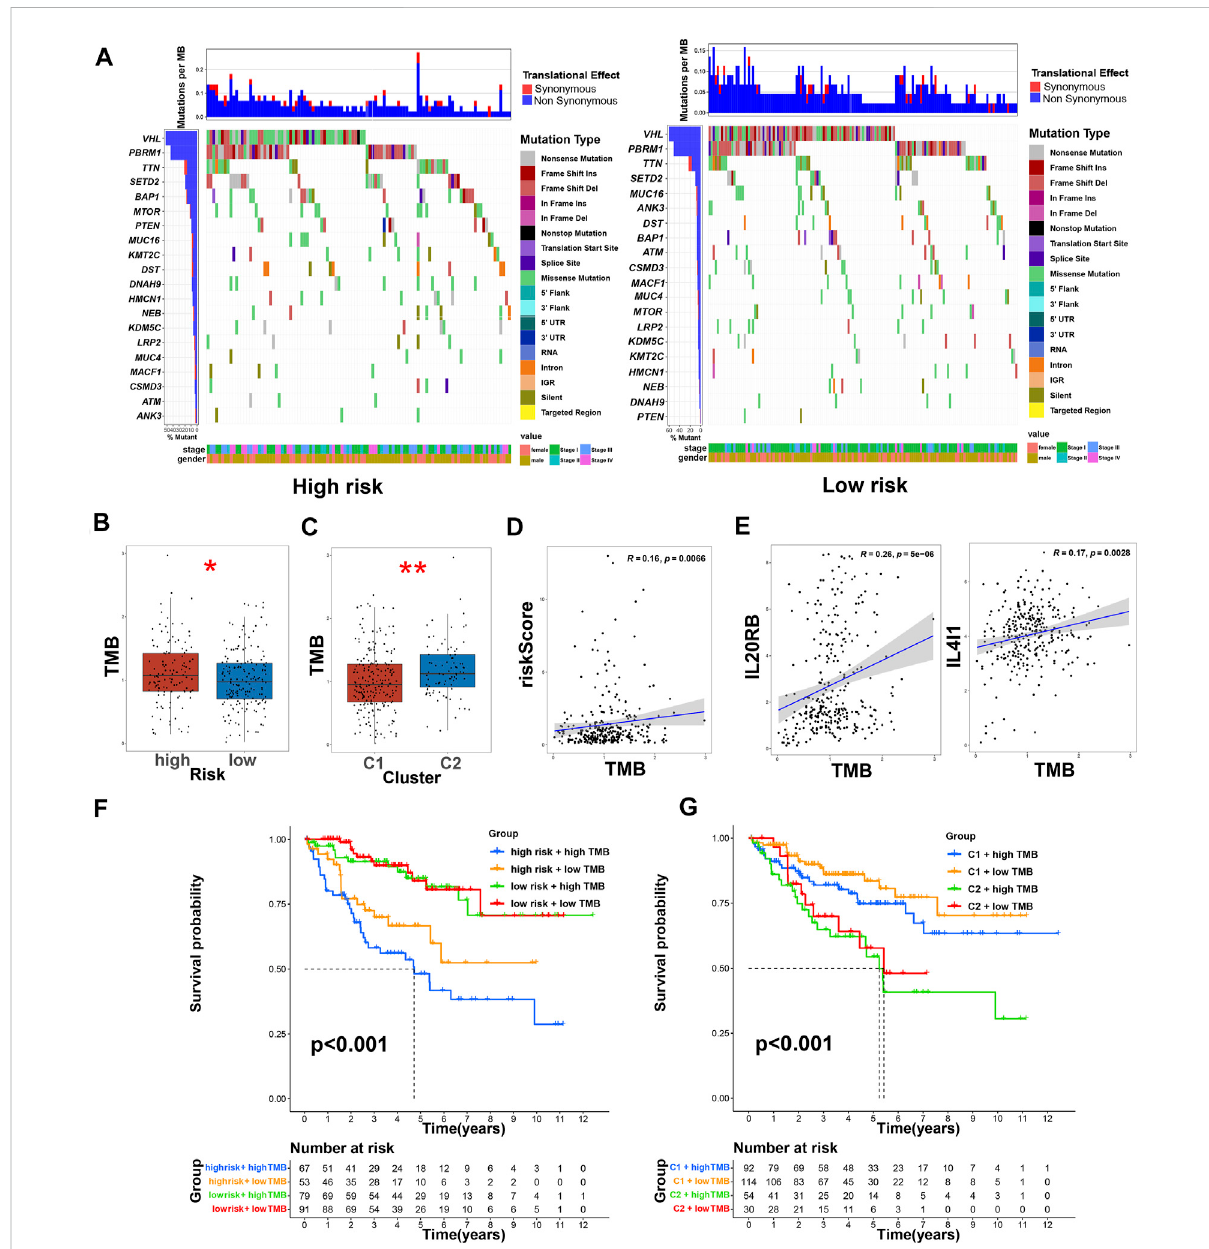
FIGURE 11 TMB and immunotherapy prediction ofccRCC patients. (A) The comparison of mutations of differentiallyexpressedTRGsinhigh- and low-risk groups; (B) thecomparisonofTMBbetweenlow-andhigh-riskgroups,*means p < 0.05; (C) thecomparisonofTMBbetweenclusters,**means p < 0.01; (D) the correlation of risk score and TMB score; (E) the correlation of TRGs and TMB scores; (F) Kaplan – Meier survival curves of OS of patients amongdifferentgroups basedonrisk scoresand TMB scores; (G) Kaplan – Meiersurvivalcurves ofOS ofpatients amongdifferentgroups based on clusters and TMB